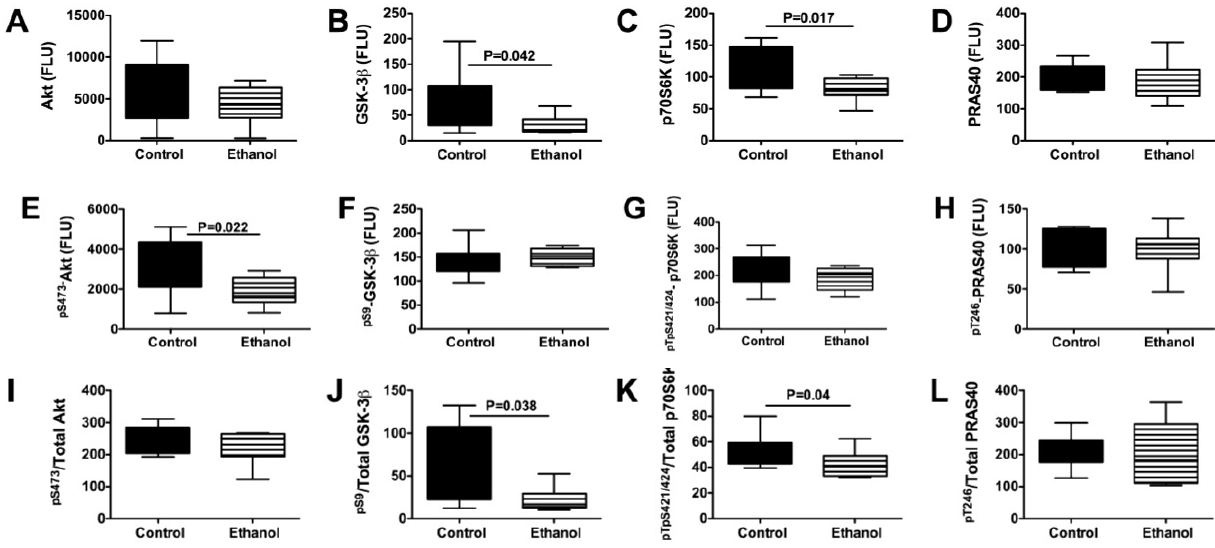
Figure 3. Effects of chronic ethanol feeding on downstream mediators of insulin/IGF signaling networks in skeletal muscle. Gastrocnemius muscles from control and chronic ethanol fed rats were used to measure immunoreactivity to ( A ) Akt; ( B ) glycogen synthase kinase 3β (GSK-3β); ( C ) p70S6 Kinase (p70S6K); ( D ) PRAS40; ( E ) pS473-Akt; ( F ) pS9-GSK3β; ( G ) pTpS421⁄424-p70S6K; and ( H ) pT246-PRAS40, and relative levels of phosphorylated ( I ) Akt; ( J ) GSK-3β; ( K ) p70S6K; and ( L ) PRAS40 using multiplex bead-based targeted ELISA panels. Immunoreactivity is expressed in fluorescent light units corrected for protein input. Inter-group comparisons were made by Student t